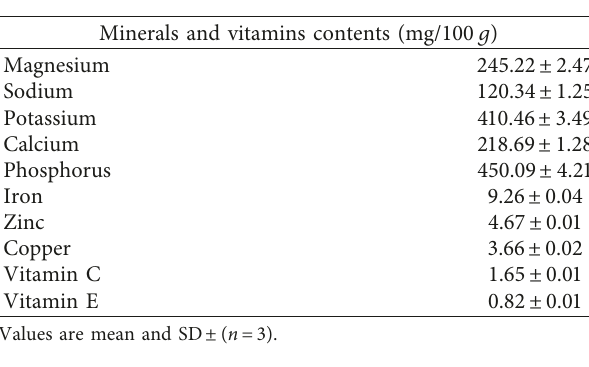
Figure 1: Chemical compositions and dietary fiber contents de- termined in the chia seeds. Table 1: Mineral and vitamin contents in chia seeds.